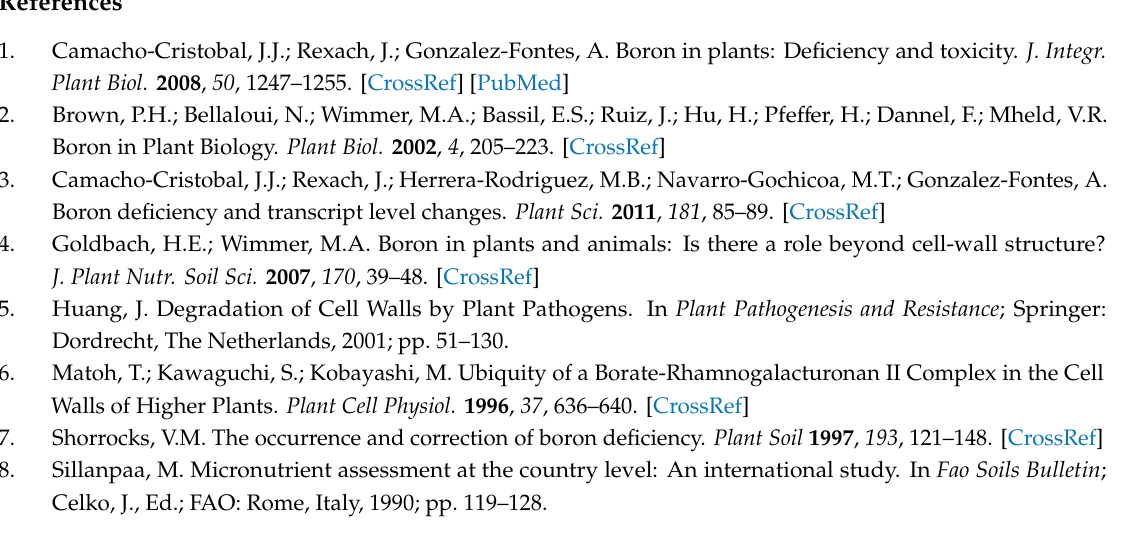
qRT-PCR. Table S2. Major characteristics of the two libraries. Table S3. Significantly di ff erentially expressed genes. Table S4. GO term analysis of significantly di ff erentially expressed genes. Table S5. Functional categories of significantly di ff erentially expressed